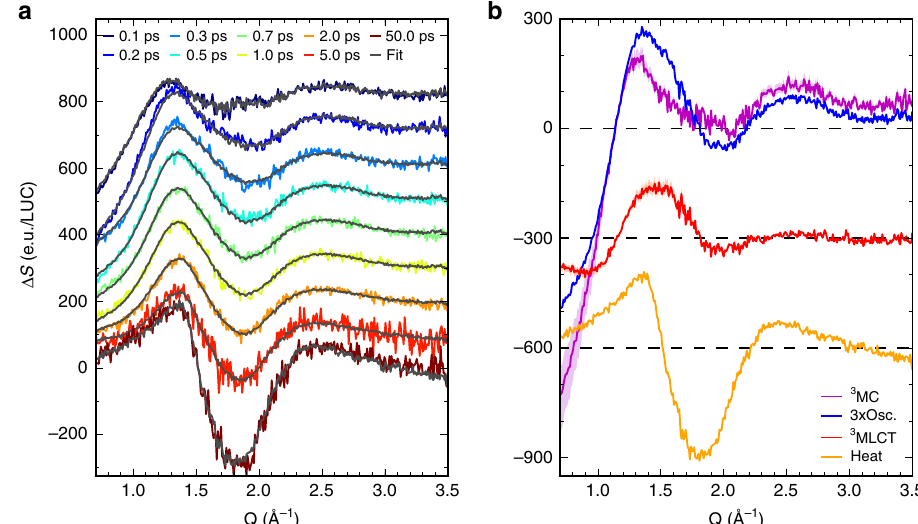
Fig. 4 Global fi t of the time-resolved isotropic XSS data based on the SVD. a Difference XSS scattering signals (colored lines) and fi ts (black lines) at selected time delays (offset step 100 e.u./LUC). b Difference XSS signals of the time-dependent components derived from global analysis: 3 MC scattering signal (magenta line), oscillatory signal (blue line, scaled by factor of 3), 3 MLCT signal (red line) and MeCN heating signal (orange line). All signals are normalized to electronic units per liquid unit cell